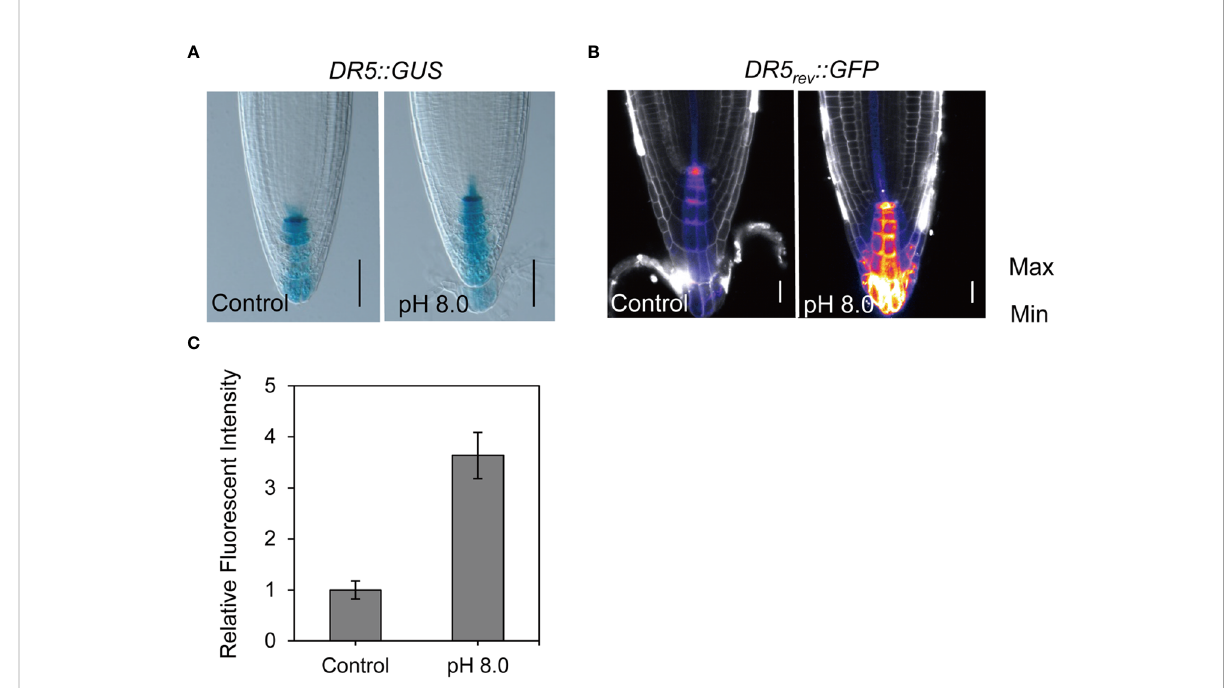
FIGURE 2 Alkaline stress increases the auxin signal in root. (A) Staining renderings of the auxin reporter DR5::GUS . The DR5::GUS transgenic seedlings were grown at pH 5.8 (control) or pH 8.0 for 6 d before recording. Scale bar, 50 m m. Increased GUS signal indicates elevated auxin level. (B) False color of DR5rev::GFP images helps to visualize the fl uorescence intensity. (C) Statistical analysis of DR5rev::GFP reporter as shown in (B) . Auxin reporter lines DR5rev::GFP were grown at pH 5.8 (control) or pH 8.0 for 6 d before imaging. n > 20. Scale bar, 20 m m. Statistically signi fi cant differences were determined by using student ’ s t-test (*** P <